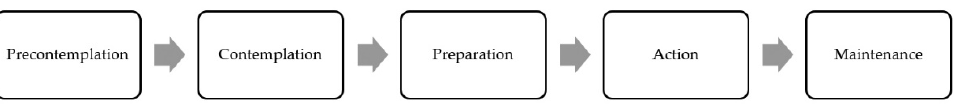
Figure 1. Stages of the transtheoretical model of change.